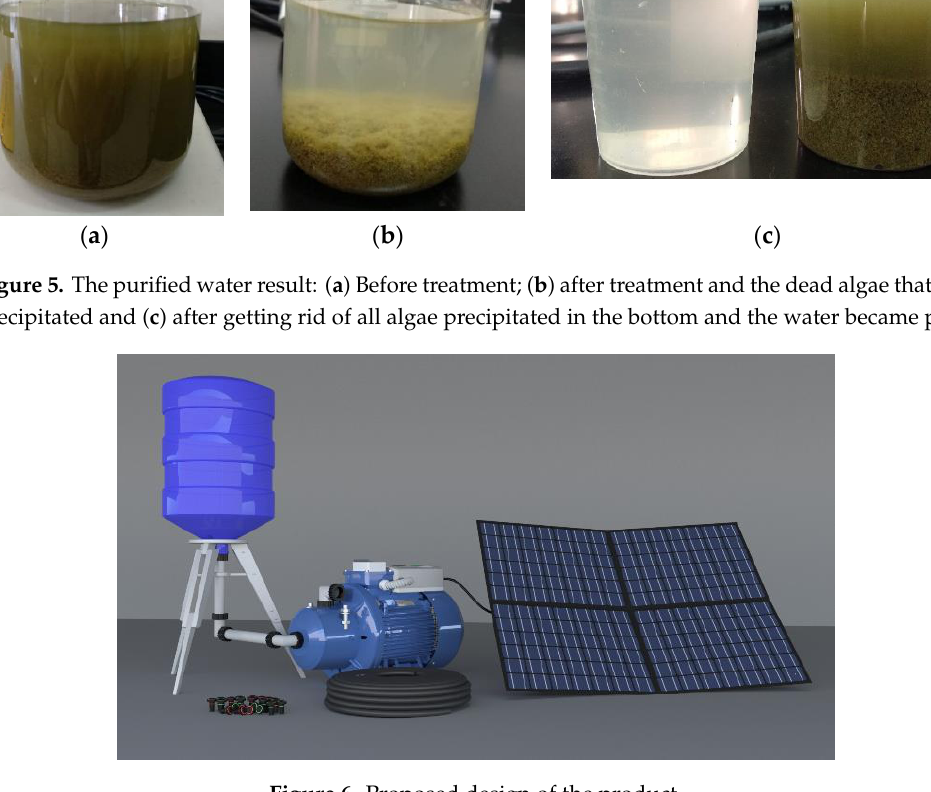
Figure 6. Proposed design of the product.